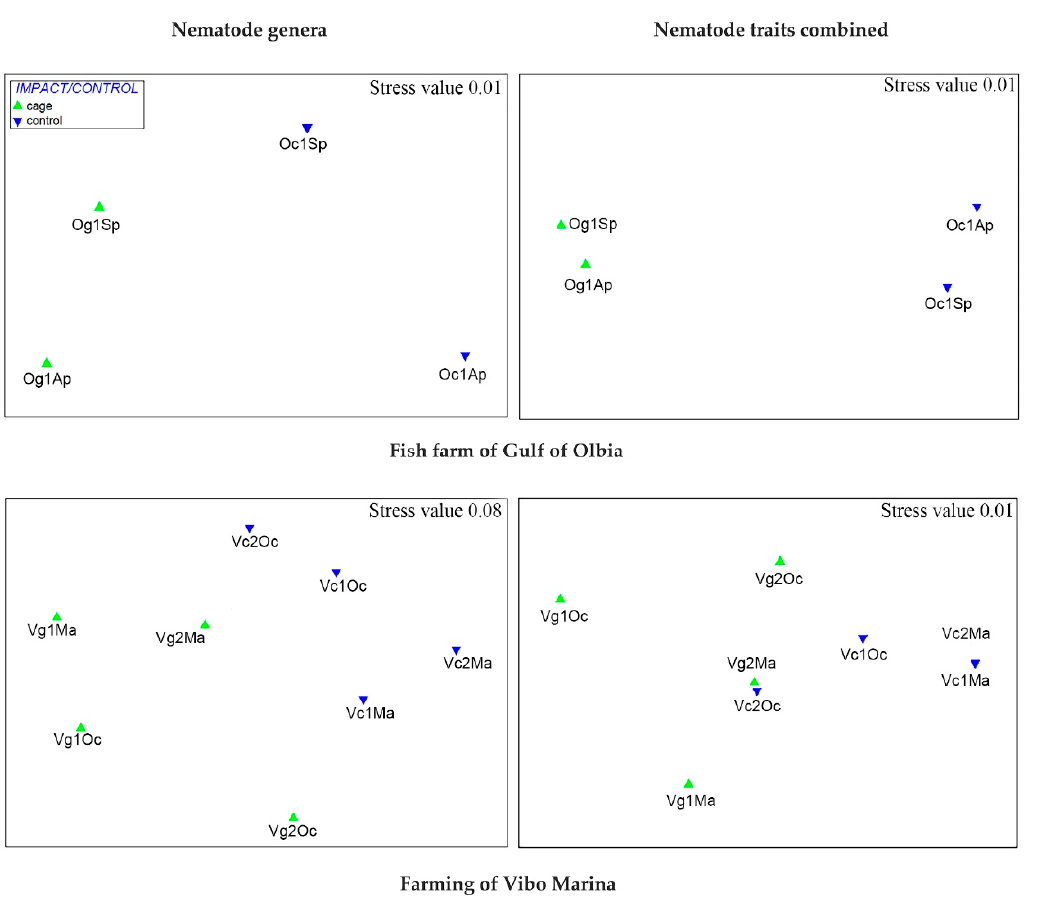
Figure 8. nMDS carried out on untransformed data matrixes of both nematode genera and functional trait codes (Bray–Curtis similarity) from fish farm sediments (Tyrrhenian Sea) (Ap = April; Ma = May; Sp = September; Oc = October). Table 1. Results of Analysis of Similarities (ANOSIM) performed to detect the presence of signifi- cant differences among the stations and sampling periods of each study case (n.s. indicates when significant differences were not found).